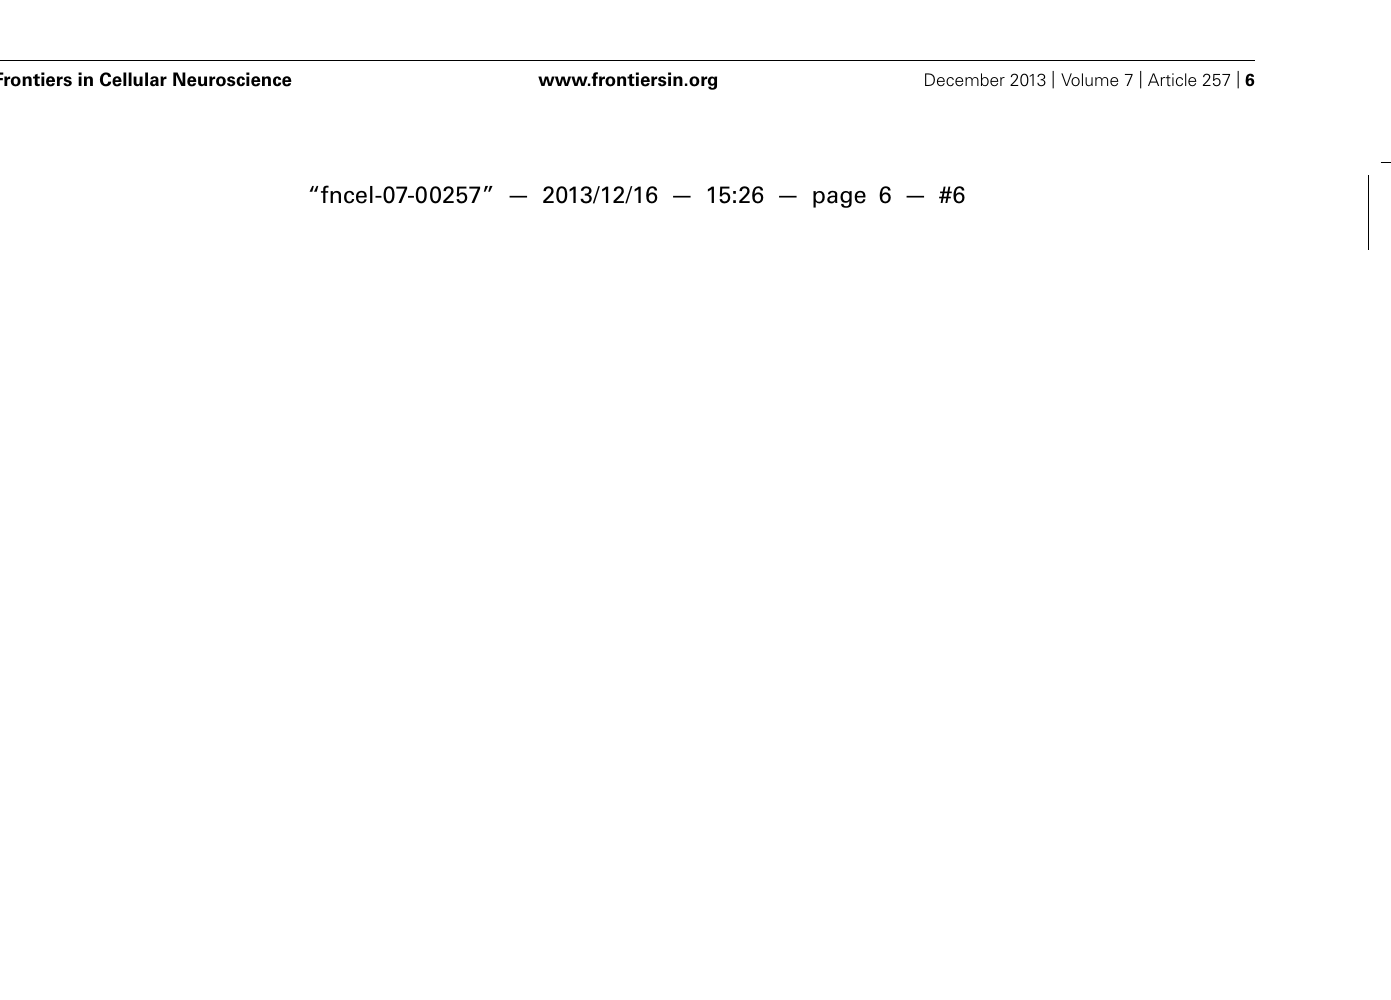
represent mean ± SEM; ** p < 0.01; n.s., not significant. (C) In situ hybridization for TNF α -mRNA (red) and GFAP-immunostaining (green) at 2 dpl. TNF α -mRNA granules colocalized with GFAP-immunofluorescence. While most TNF α -mRNA/GFAP-positive cells were detected in the OML (arrowheads) and some in the IML (arrow), only a weak TNF α -mRNA signal was present in the GCL (mostly in colocalization with GFAP). These results indicate that astrocytes could be a major source of TNF α following entorhinal denervation in vitro . Scale bar: 50 μ m. (D) Higher magnification of the OML. TNF α -mRNA granules can be identified in the soma and proximal processes of GFAP-positive cells (ToPRO nuclear staining, blue; n = 4 cultures). Scale bar: 10 μ